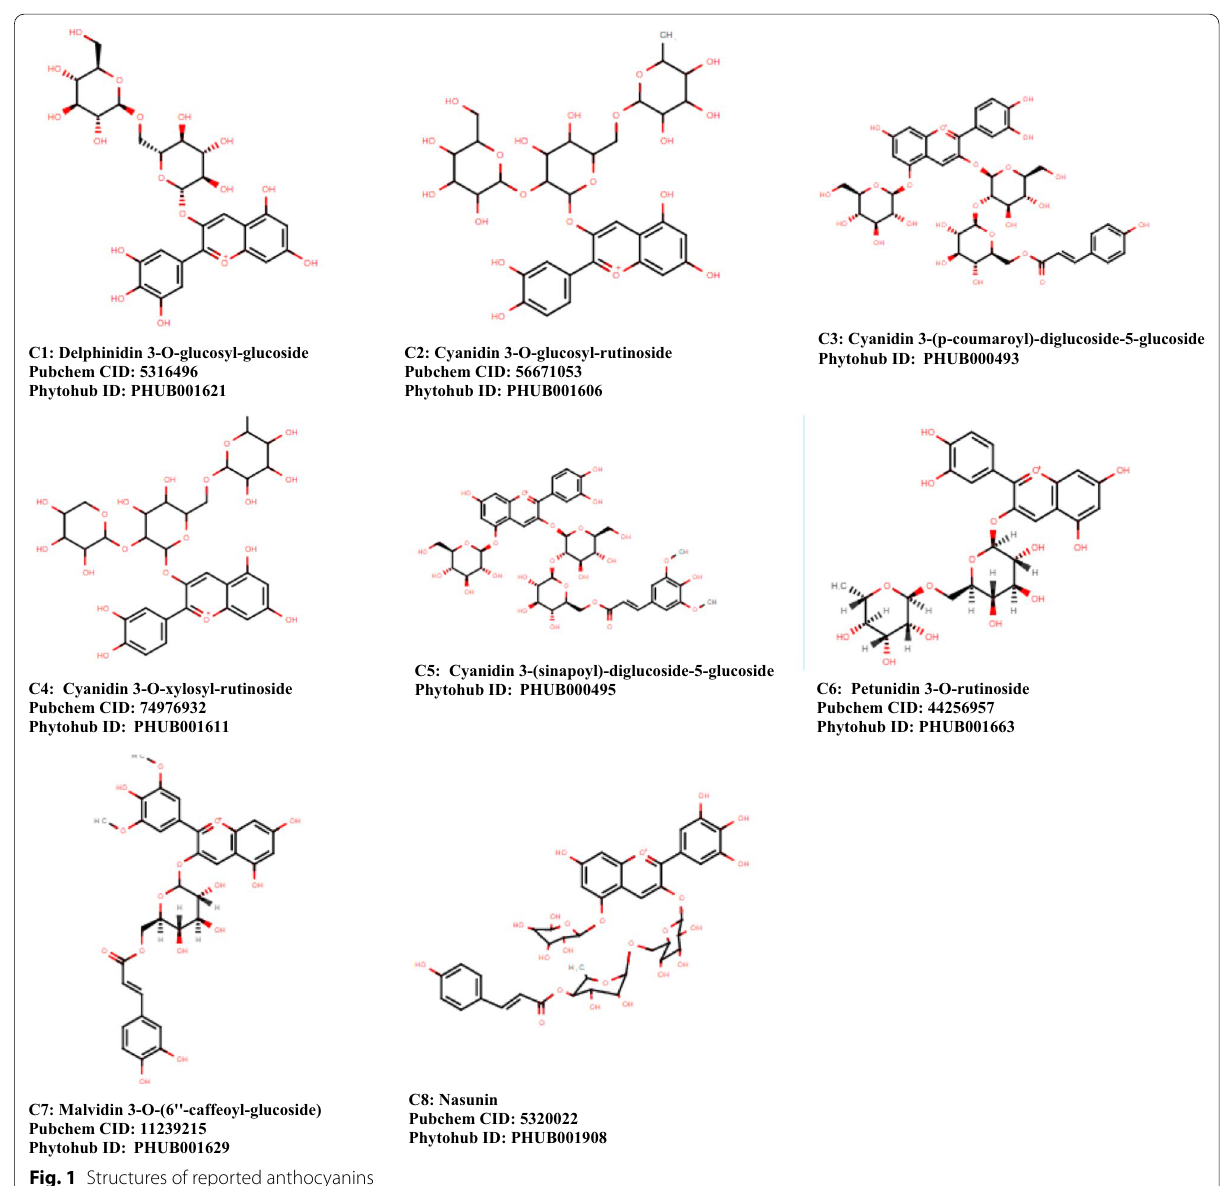
Fig. 1 Structures of reported